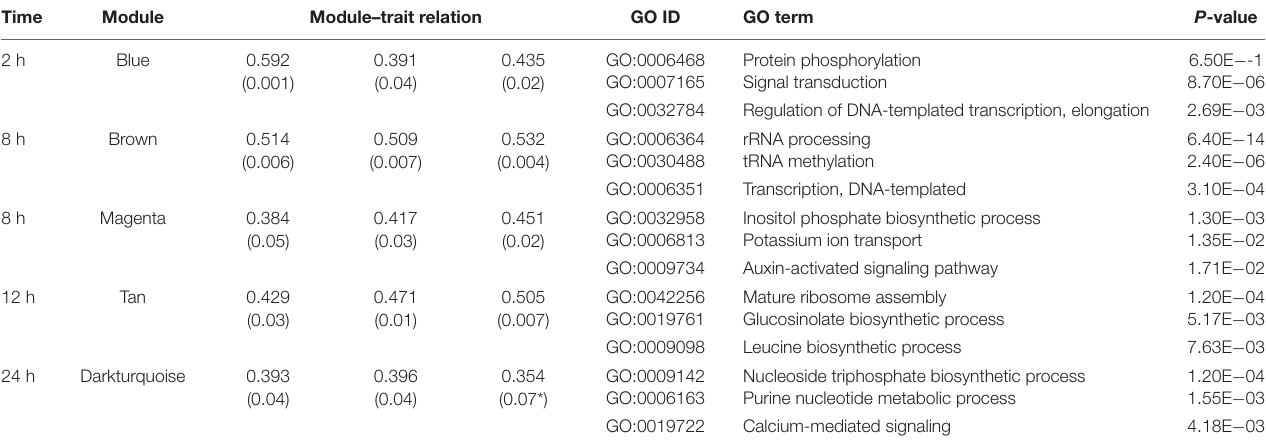
TABLE 1 | Module–trait relation and gene function enrichment information of genes in salt stress responding time points related